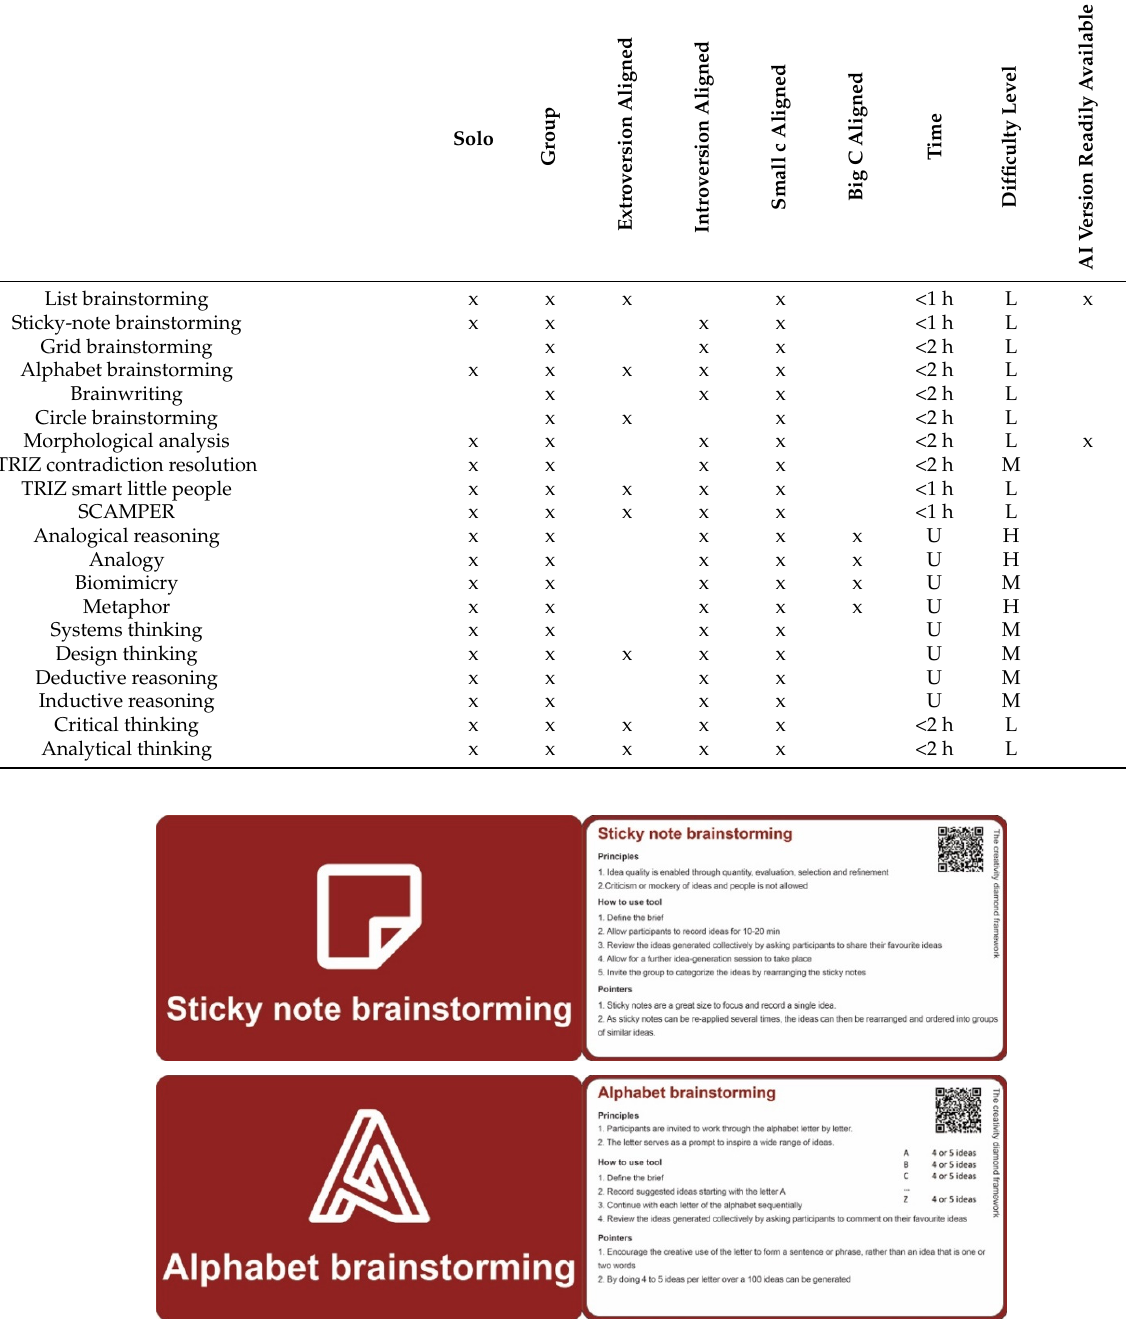
L = low; M = medium; H = high; U = unspecified; h = hour.